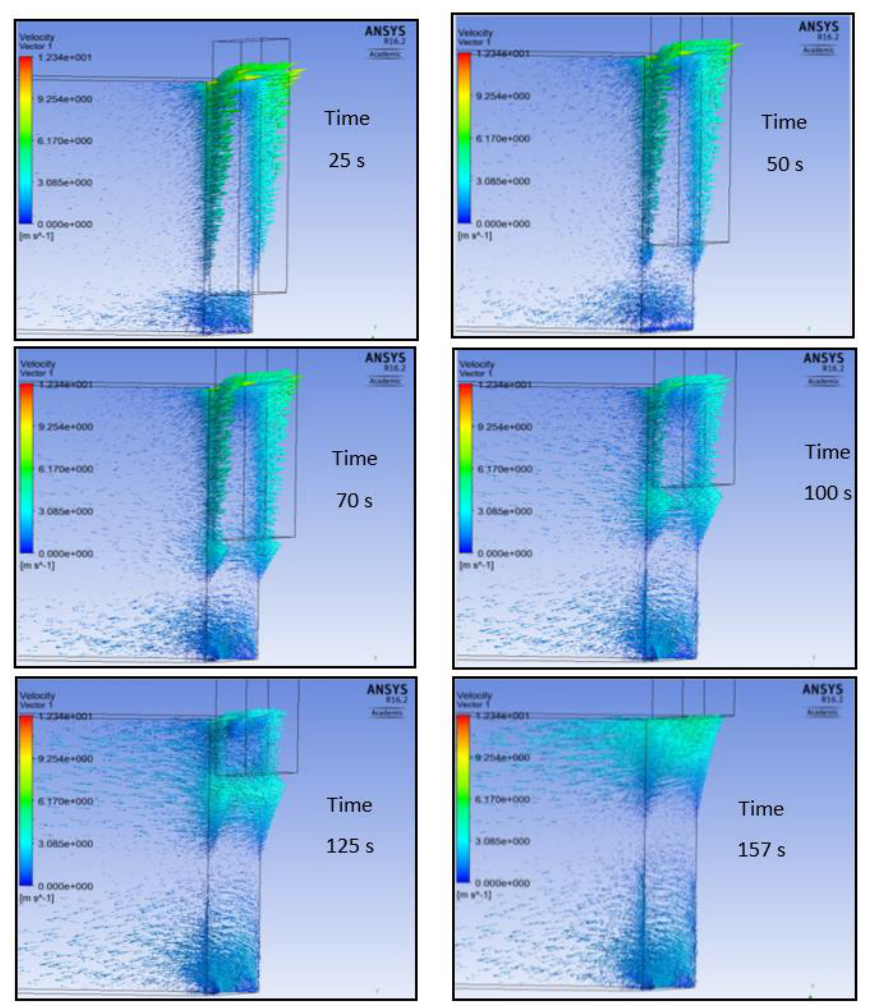
Figure 7. Fluid motion during the transient time from the opening of the door, up to the complete opening of 4.7 m at 157 s.